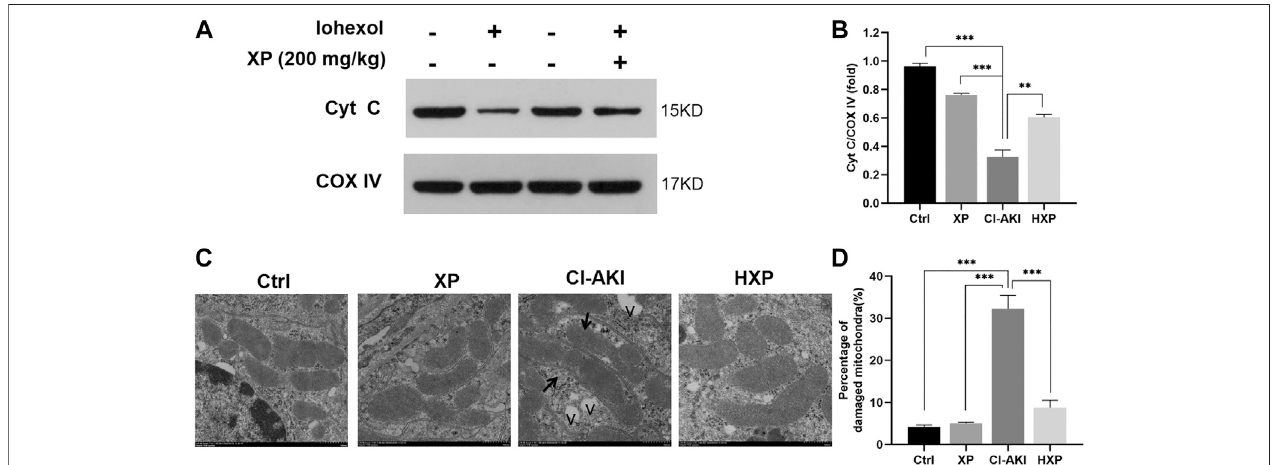
FIGURE5 | Mitochondrial enzyme cytochrome c(Cyt C) assessments inkidneys. (A) Western-blotting analysisshowed the majority ofthe Cyt Cprotein appeared in the mitochondria fraction of Ctrl, XP and HXP groups. However, a signi fi cant reduction of total Cyt C protein expression in the mitochondria fraction was observed in iohexol-induced animals. (B) Densitometric analysis (protein quanti fi cation) of western blotting signals using image J software. Fold change in each protein level normalized to COX IV is shown numerically. (C) Mitochondrial ultrastructure of the kidney tissues were scanned using Transmission electron microscopy (TEM) (Scale bar: 500 nm). “ v ” indicated vacuolization. (D) Data were shown as a plot of the percentage of damaged mitochondria from 10 images of each group. Data are presented as mean ± SEM ( n (cid:1) 6 in each group). * p < 0.05; ** p < 0.01; *** p < 0.001 based on one-way analysis of variance. Representative images are presented. TUNEL, Cyt C, cytochrome c; COX IV, cytochrome c oxidase IV, TEM, transmission electron microscope; Ctrl, control; CI-AKI, contrast induced-acute kidney injury; HXP, high dose XP combined with iohexol.